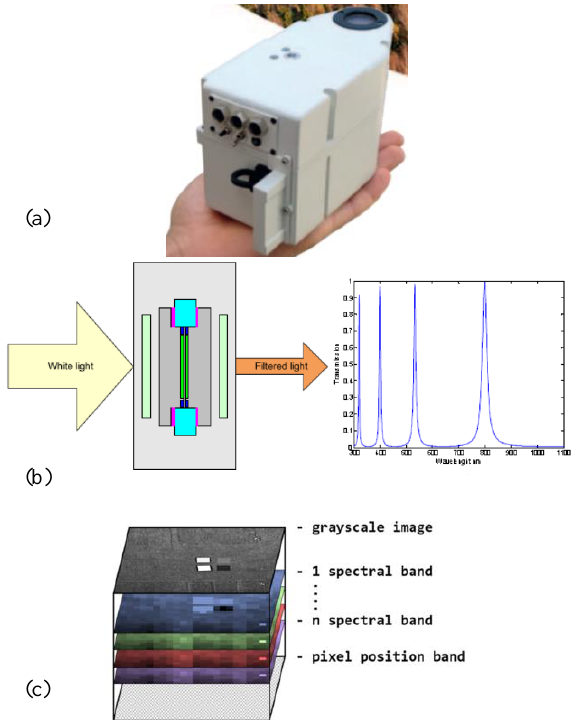
Figure 1: (a) Hyperspectral frame camera. (b) Fabry-Perot principle. (c) Image data cube. Source: adapted from (b) Rikola Ltd. and (c) Aasen et al.